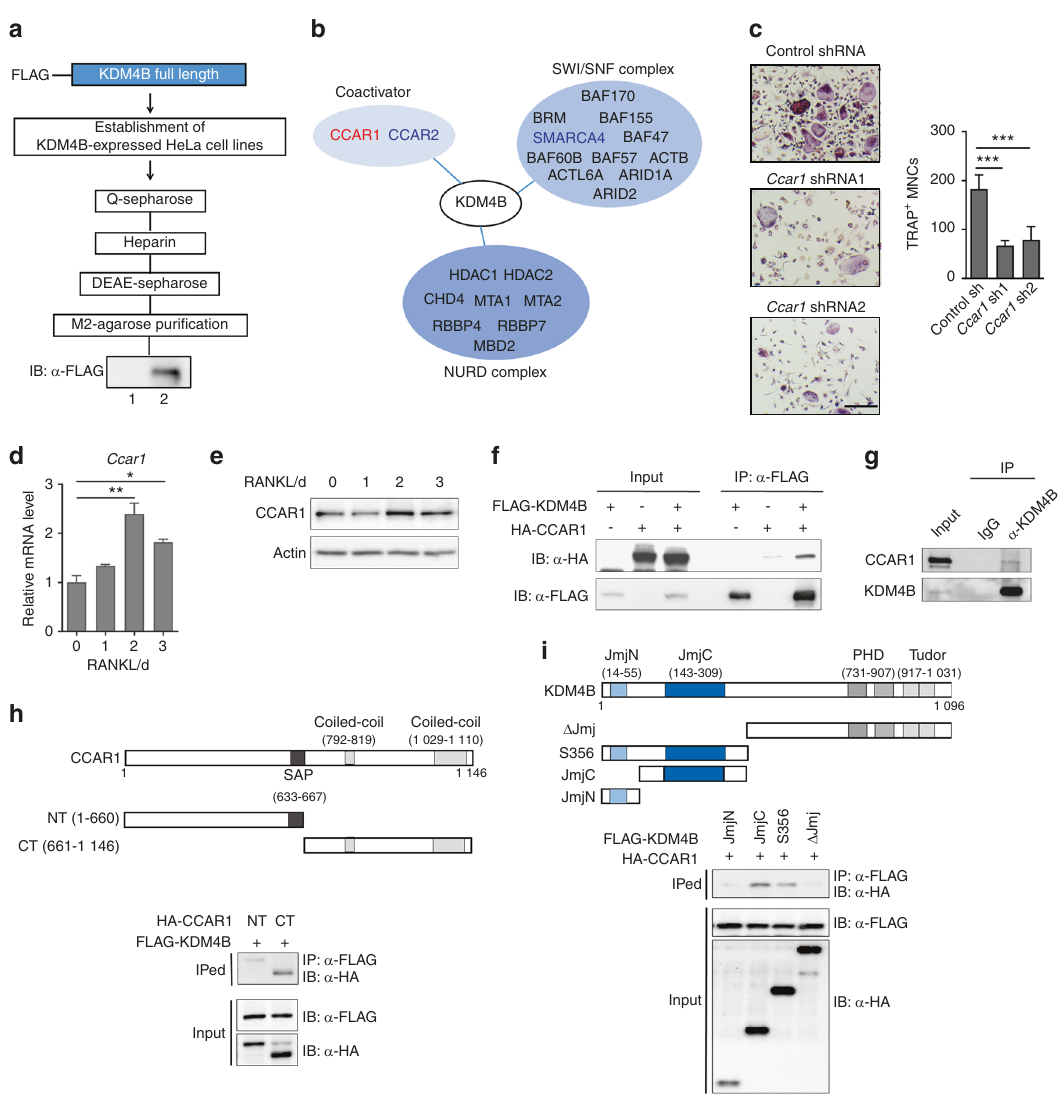
Fig. 2 KDM4B associates with CCAR1. a Schematic diagram of the method used to purify the KDM4B-interacting complex from FLAG-KDM4B- expressing cells. Lane 1, control preparation from the nuclear extract of normal HeLa cells; lane 2, KDM4B-interacting complex from the nuclear extract of KDM4B-expressing HeLa cells. b KDM4B-interacting complexes. c TRAP staining of BMMs expressing either control shRNA or Ccar1 1 shRNA1. Scale bar, 75 μ m. d , e CCAR1 expression during osteoclast differentiation. qRT-PCR ( d ) and immunoblot ( e ) results. f Coimmunoprecipitation of FLAG-KDM4B and HA-CCAR1. g Endogenous interaction of KDM4B and CCAR1 in BMMs. h , i Mapping the binding domain of KDM4B and CCAR1. JmjN N-terminal jumonji domain, JmjC jumonji C-terminal domain, PHD plant homeodomain fi nger domain, Tudor Tudor domain. SAP, SAF-A/B, Acinus, and PIAS DNA/RNA binding motif. The data are presented as the mean ± SD values of three independent experiments [one-way ANOVA in ( c , d )]. * P < 0.05; ** P < 0.01; *** P < 0.001. See also Supplementary Fig.